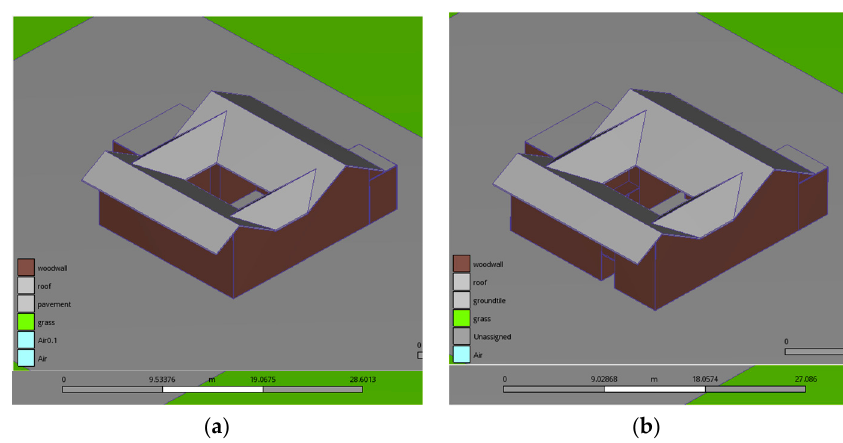
Figure 6. Models for the CFD simulation: ( a ) enclosed courtyard model, and ( b ) open courtyard model.